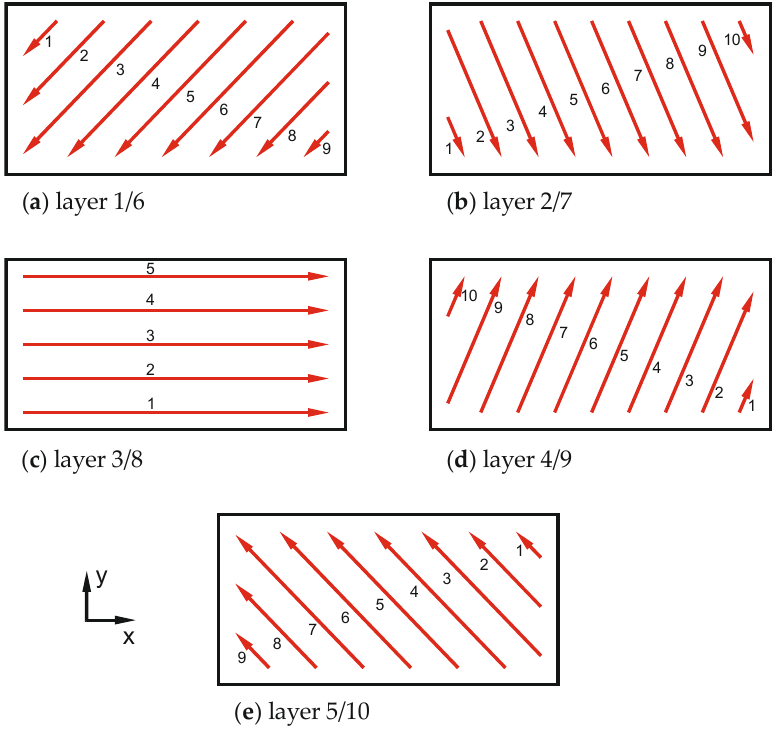
Figure 6. Scanning strategy—67° rotation.